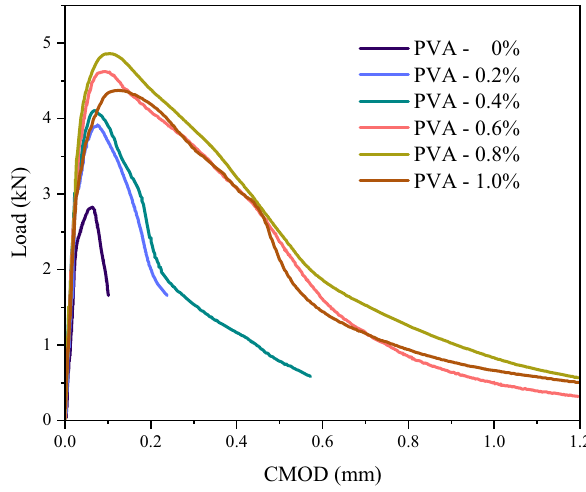
Figure 21: Load – CMOD curve.